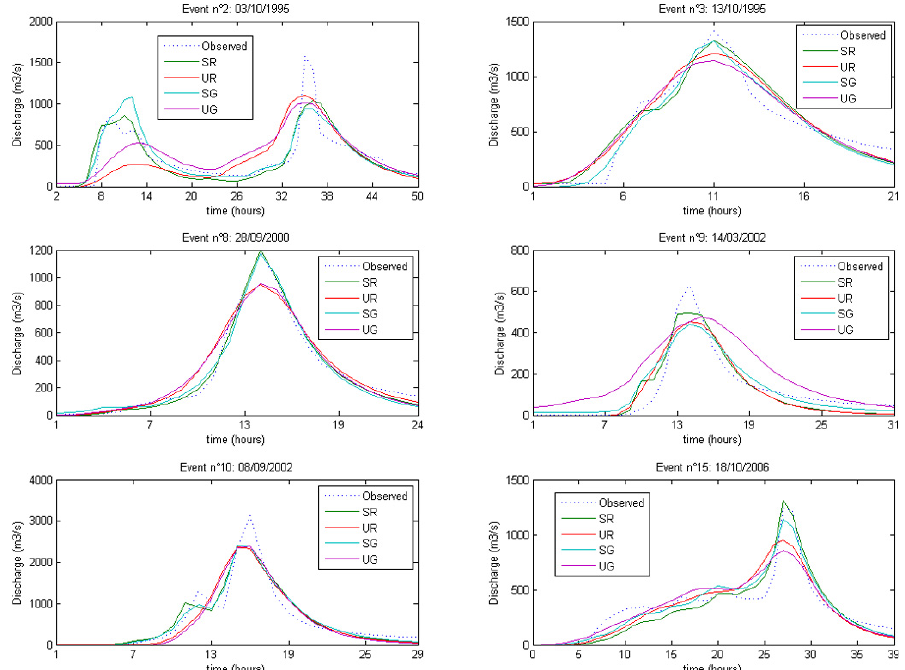
Fig. 8. Simulated and observed flood hydrographs for the 6 most important events, corresponding to the alerts level “orange” and “red”, using the different rainfall inputs.